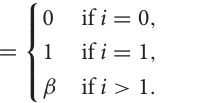
FIGURE 2 | Comparison of transition rates, F i for simple contagion (SI) and complex contagion (CC). Here β